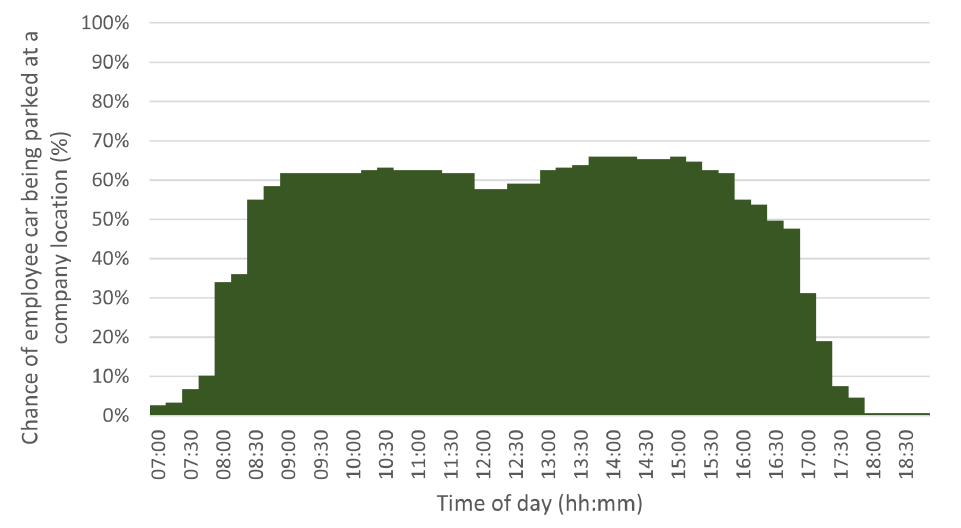
Figure 5. Chance of a car being parked at a company location at a certain time of day, for all employee